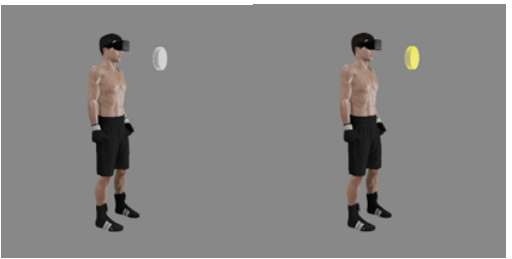
Figure 1. Visualization of the test used for analyzing simple reactions in VR (gray — waiting for the stimulus, yellow — right hand reaction).